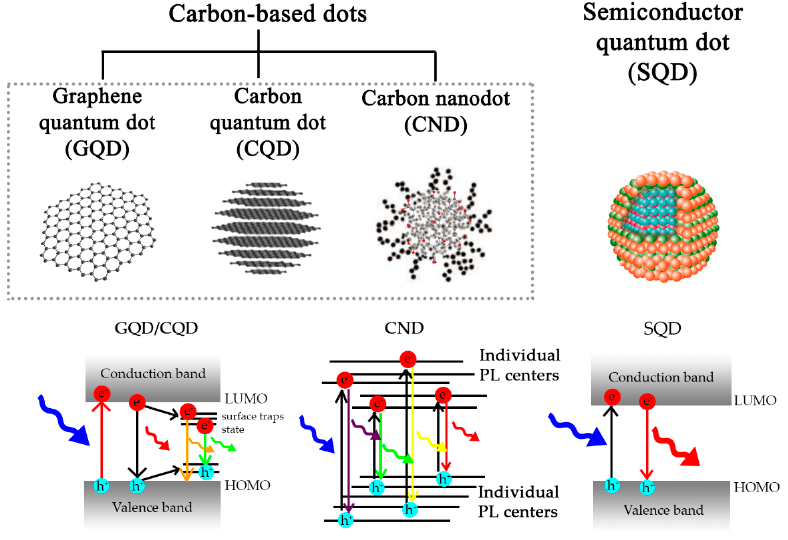
Figure 5. Schematic illustration and photoluminescent mechanism of carbon-based dots, including graphene quantum dot (GQD), carbon quantum dot (CQD), carbon nanodot (CND), compared to the quantum dots made of semiconductor (SQD).